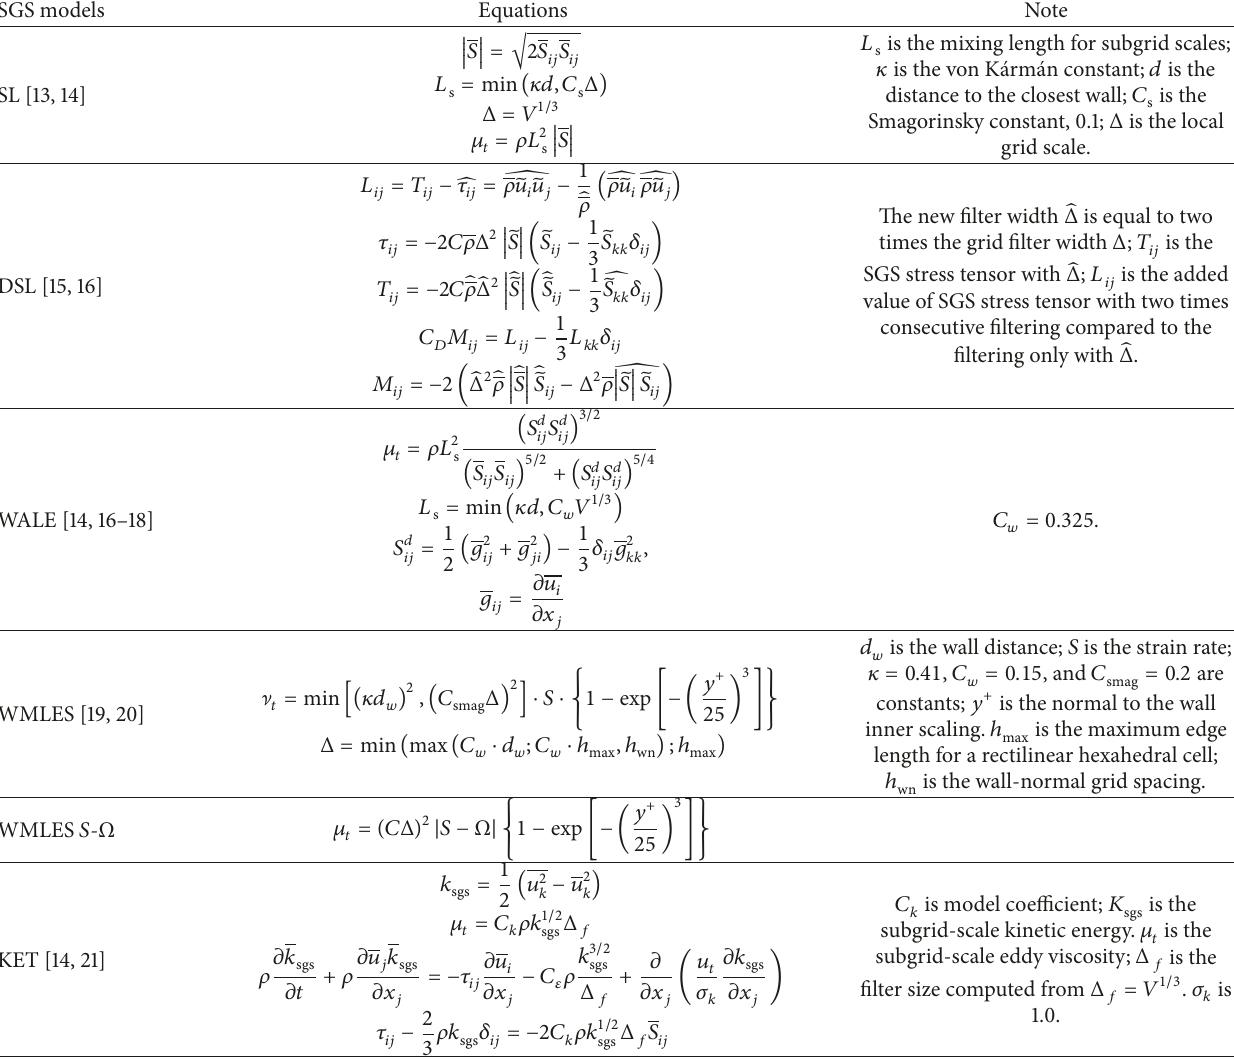
Table 1: The equations of the six SGS models.